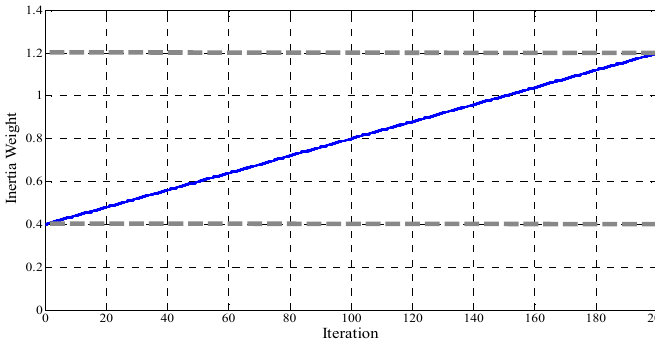
Figure 8. Behavior of inertia weight during all iterations.